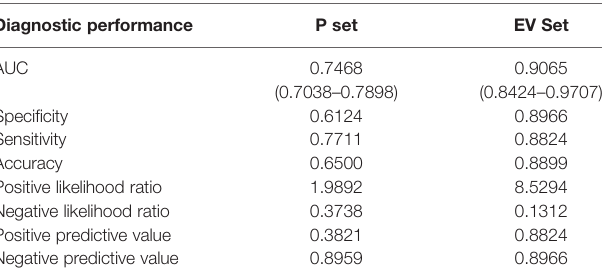
TABLE 4 | Diagnostic performance of the